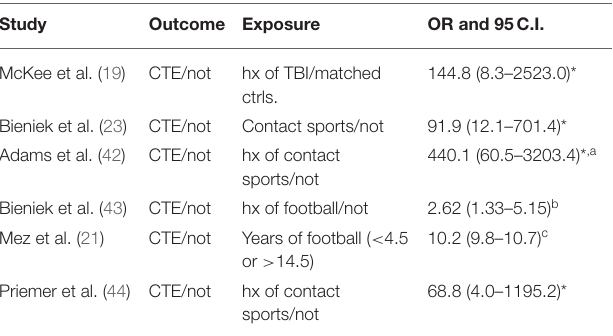
TABLE 1 | Odds ratios from important case-control studies (in chronological order of publication). Study Outcome Exposure OR and